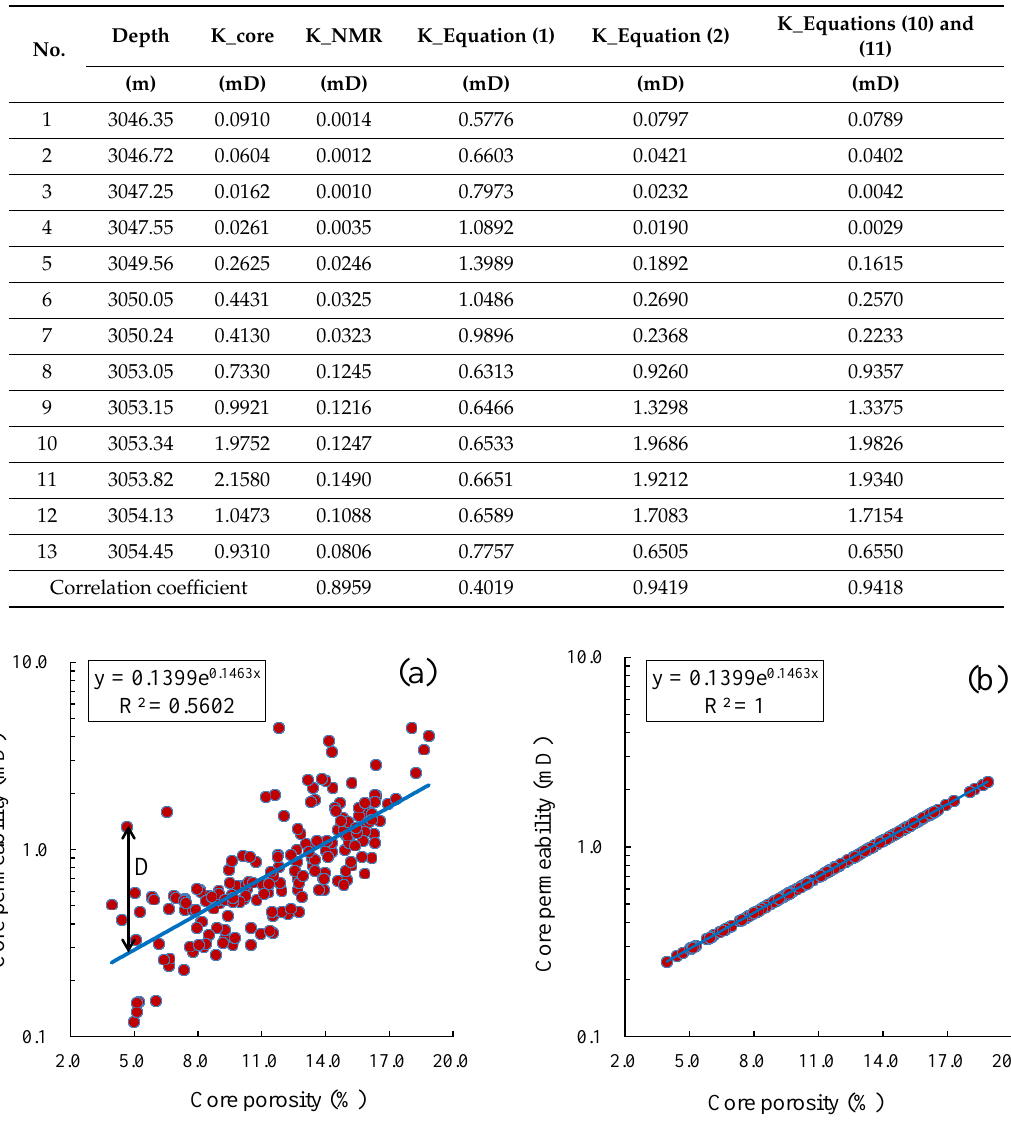
Figure 2. The cross-plot with 200 core samples: ( a ) Core samples, and ( b ) samples that eliminate reservoir quality index differences using trend lines as a standard. Table 1. Core physical property parameters obtained by nuclear magnetic resonance (NMR) experiments.